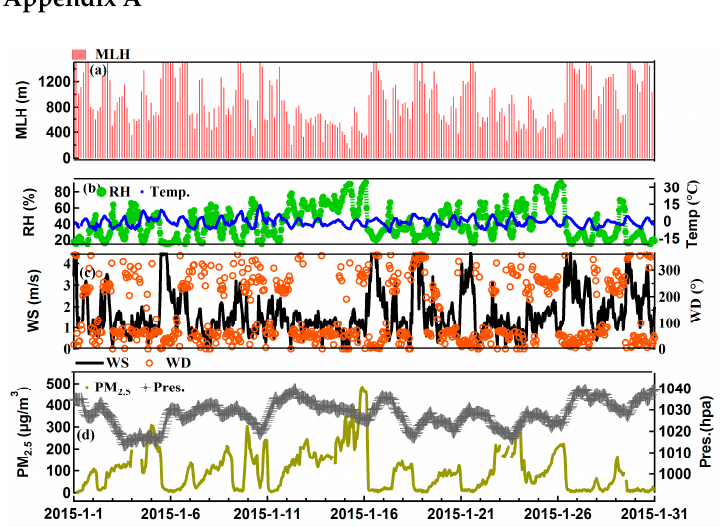
Figure A1. Time series of ( a ) Mixed layer height (MLH); ( b ) relative humidity (RH) and temperature (Temp); ( c ) wind speed (WS) and wind direction (WD); ( d ) PM 2.5 and pressure (Pres.) during January 2015 in Beijing.